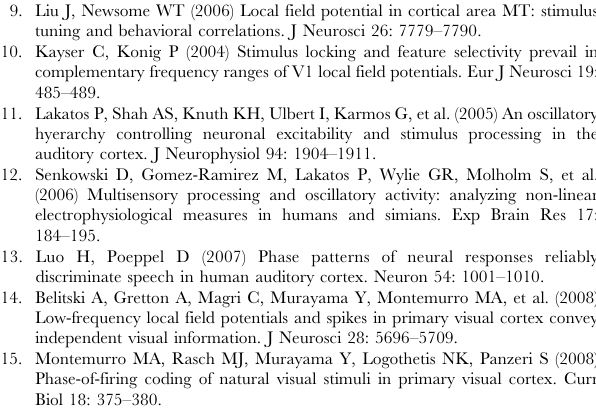
Figure S1 Signal-LFP entrainment for different amplitudes of periodic stimuli. Circular variance of the phase difference between periodic input signals of different frequencies and the LFP bandpassed at corresponding frequencies when the signal amplitude is 0.4 spikes/ms (A) and 1.6 spikes/ms (B). The entrainment is inversely proportional to the value of the circular variance Found at: doi:10.1371/journal.pcbi.1000239.s001 (0.28 MB TIF)